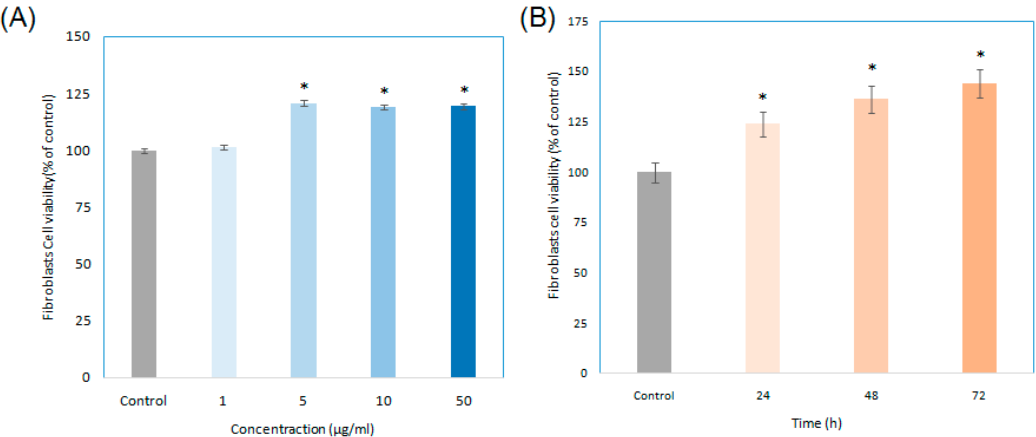
Figure 1. Enriched astaxanthin extract (EAE) effects on human cell viability with various doses and time intervals. Human skin fibroblasts were seeded in a 96-well micro titer plate which had a density of about 1 × 10 4 cells/well and ( A ) treated with 1, 5, 10, and 500 μ g/mL of EAE for 24 h; at 0 μ g/mL as the control group; ( B ) treated with 50 μ g/mL for 24, 48 and 72 h; at 0 h as the control group. The cell viability of fibroblasts were measured by 3-(4,5-Dimethylthiazol-2-yl)-2,5-diphenyltetrazolium bromide (MTT assay) 24 h after compound treatment. (Data represents mean ± S.D. of three independent experiments performed. * p <0.01).